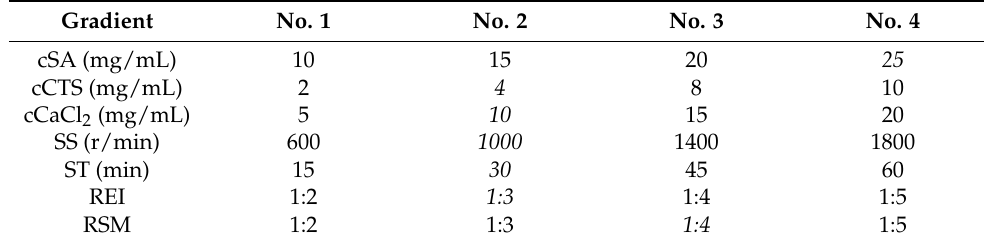
Table 1. Designation of possible factors affecting the encapsulation efficiency of MGS. Gradient No. 1 No.